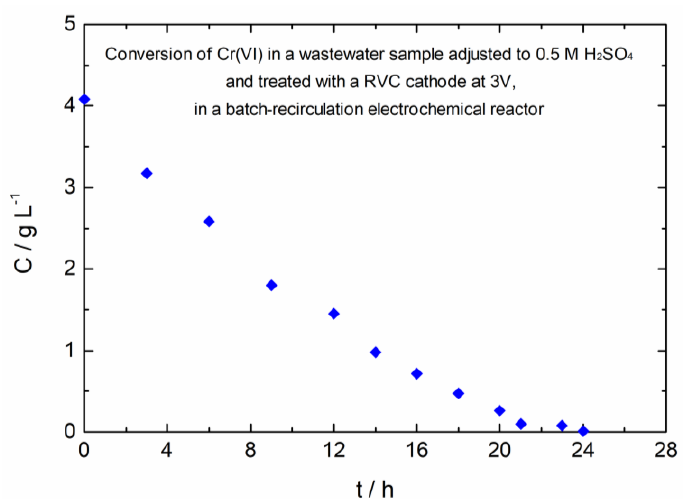
Figure 10. Concentration of Cr(VI) vs. time plots during the electrolysis of 4.1 g.L −1 , 800 mL leachate samples in a batch-recirculation type reactor with a 33 L.h −1 flow rate, using an RVC cathode electrode and a constant potential of 3 V.